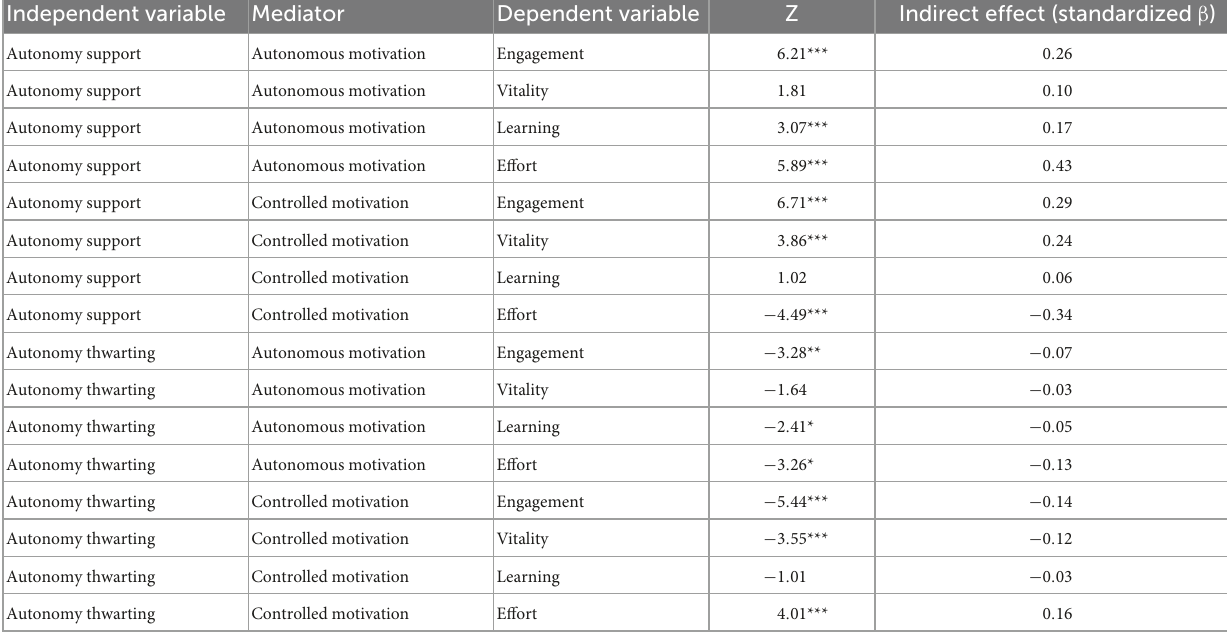
TABLE 3 Indirect effects of the relationships of the re-specified